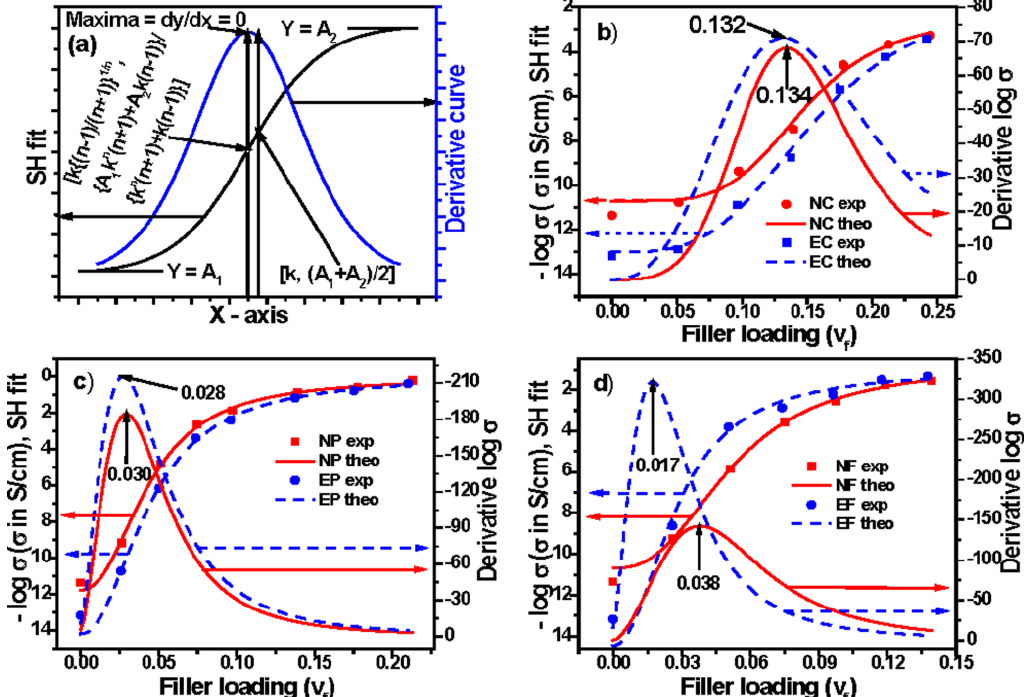
Figure 6. Experimental, theoretical, and derivative curves: ( a ) an ideal curve; ( b ) Conductex black filled; ( c ) Printex black filled; and ( d ) SCF filled composites based on Sigmoidal–Hill model.